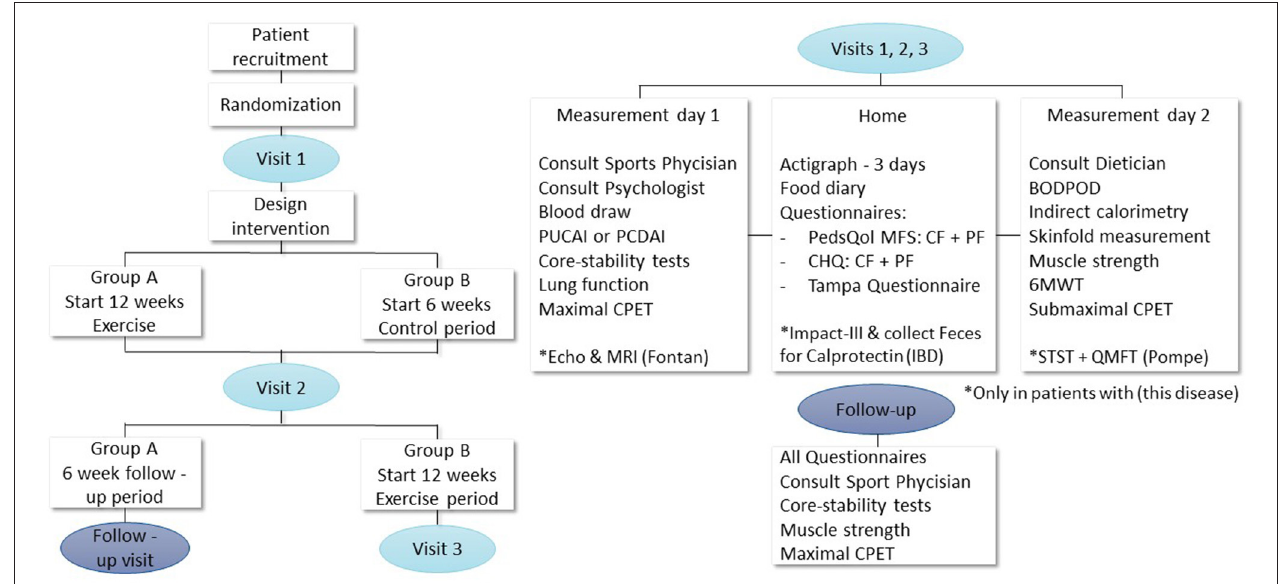
FIGURE 1 | Study design, visits, and measurements. PCDAI, Pediatric Crohn’s Disease Activity Index; PUCAI, Pediatric Ulcerative Colitis Activity Index; CPET, cardiopulmonary exercise testing; PedsQol, pediatric quality of life questionnaire; MFS, multifatigue scale; CR and PR, child and parent reports; CHQ, child health questionnaire; 6MWT, 6-minute walking test; BODPOD, body composition measurement; MRI, magnetic resonance imaging; IBD, inflammatory bowel disease; STST, sit to stand test; QMFT, quality motor function test. 80% and an alpha of 0.05 in a sample of 10 children with BPD, assuming a standard deviation of 2.19 VO 2 /kg